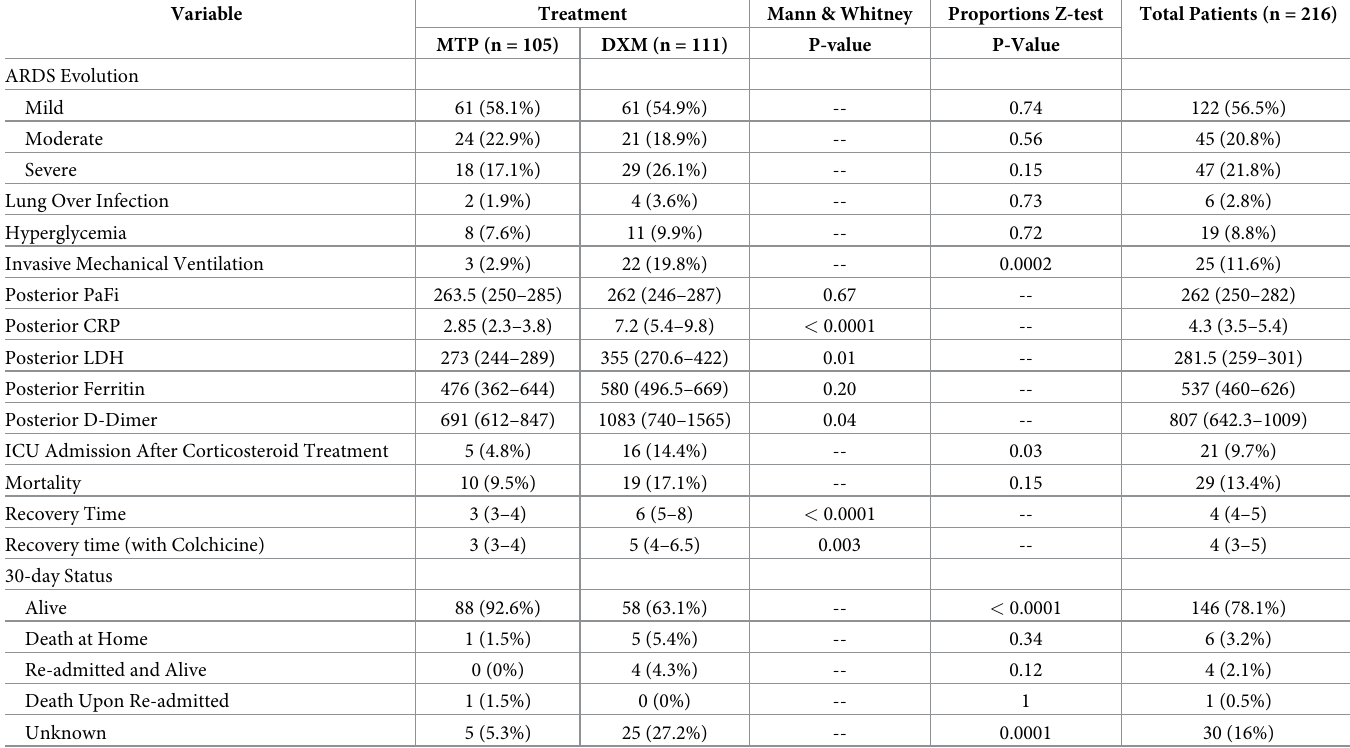
Table 2. Clinical outcome of hospitalized patients with Covid-19 pneumonia, according to the treatment